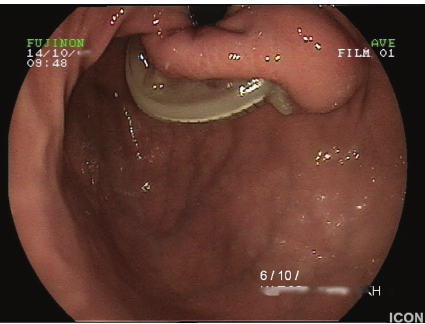
Figure 1: Retroflexed inspection of the gastric fundus and gastric erosion by the band.